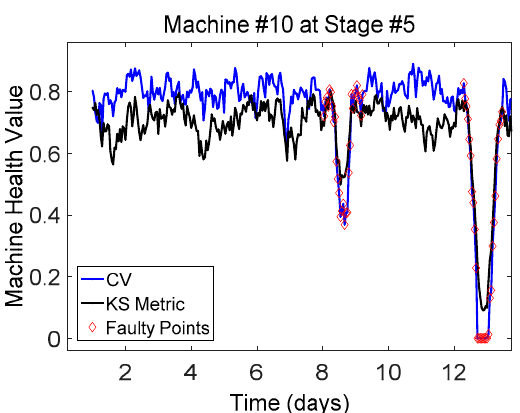
Figure 7. The calculated health value for a machine in a process with five stages and ten machines per stage. The results using the proposed metric ( CV ) and KS metric are compared. Red markers represent faulty samples.